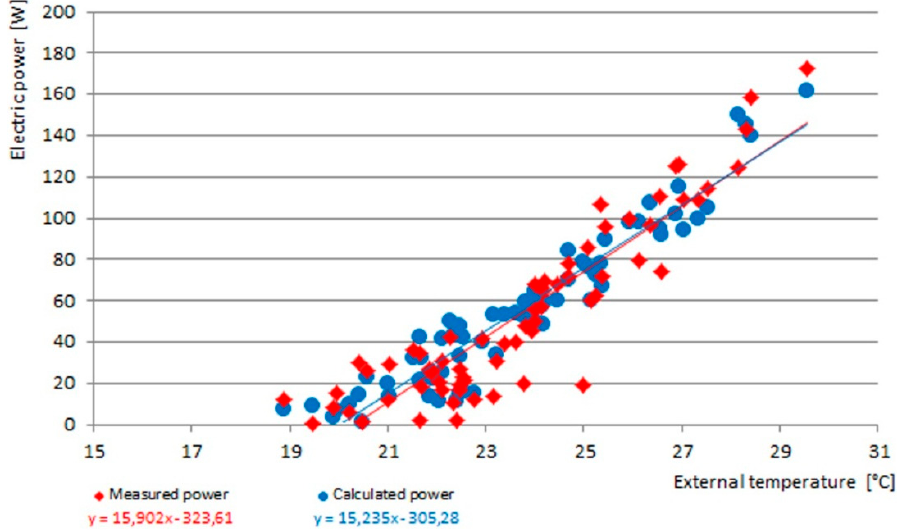
Figure 9. Comparison of the measured and calculated average daily powers through the energy signature method.